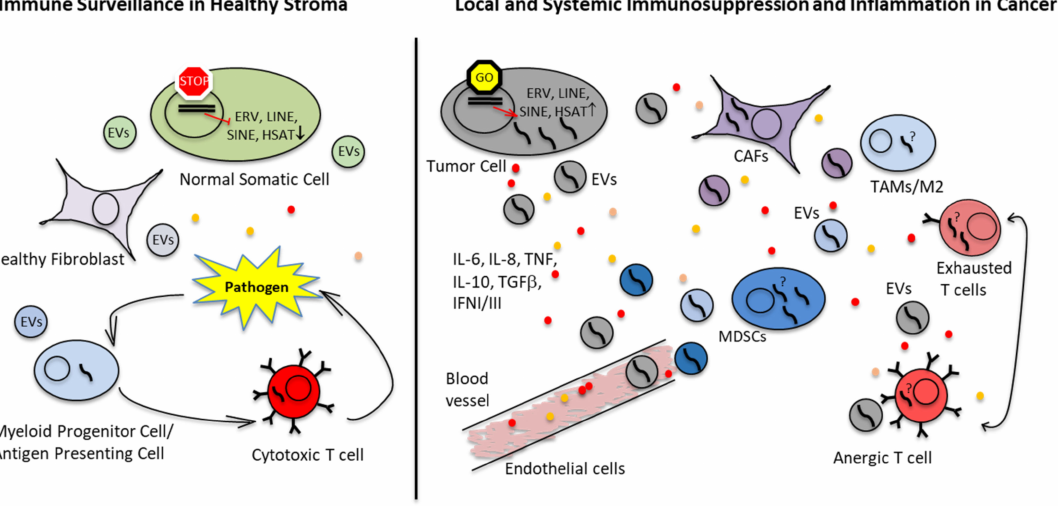
Figure 2. Immunosuppressive tumor environment and immune evasion mechanisms in EwS and OS. Oncogenic drivers and epigenetic changes in EwS, OS and other cancers activate